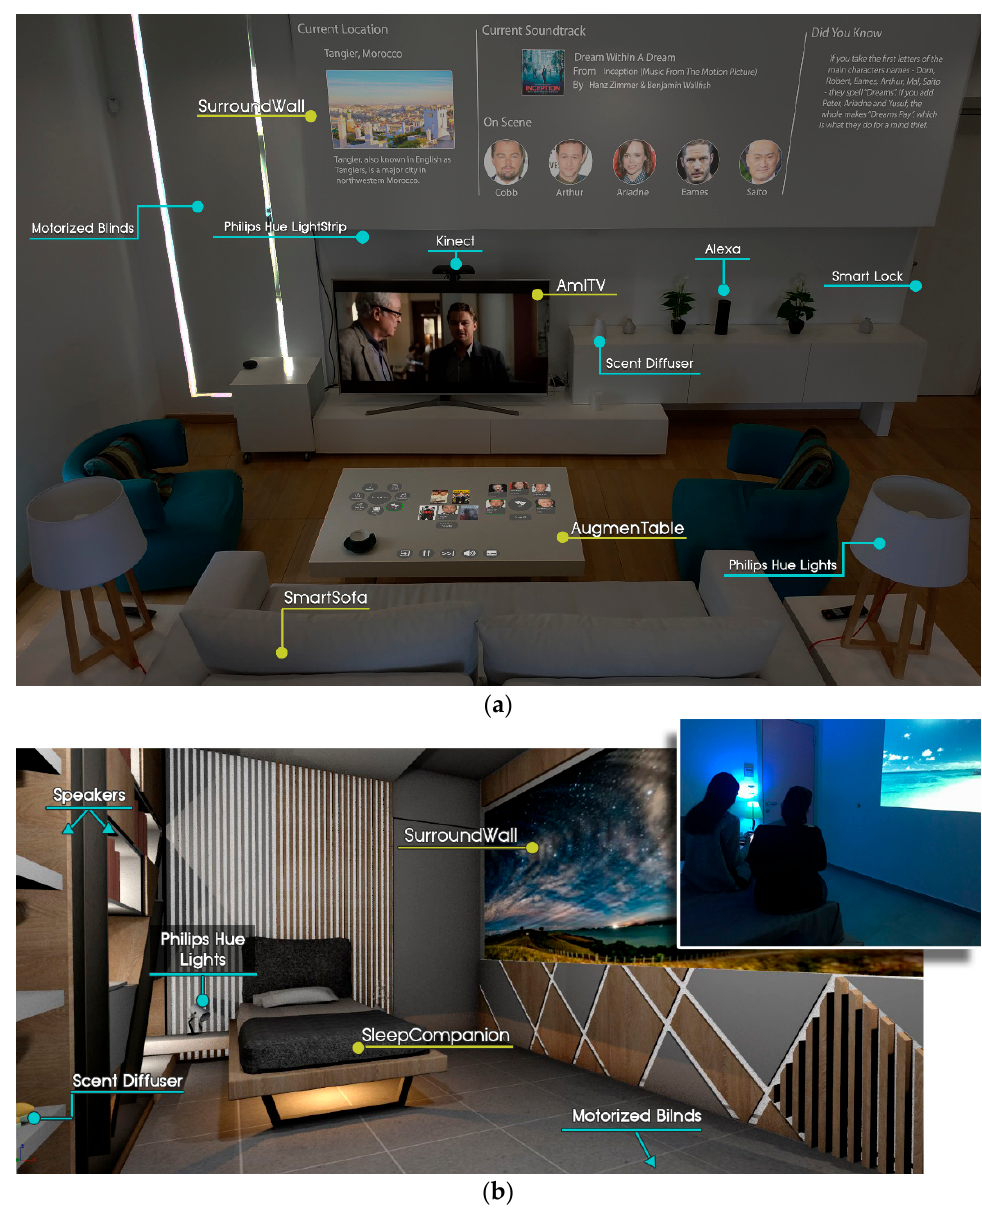
Figure 1. ( a ) the Intelligent Living Room; and ( b ) the Intelligent Bedroom.